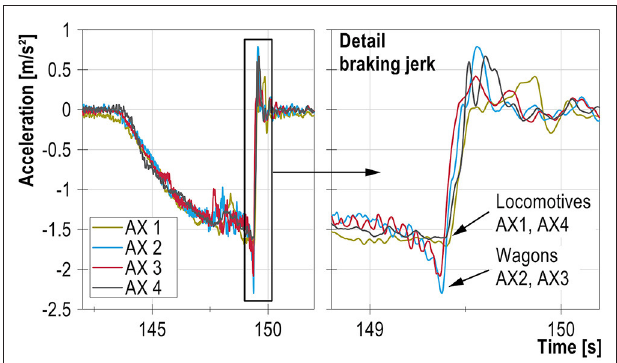
FIGURE 12 | Braking acceleration measured by the four sensors installed along the